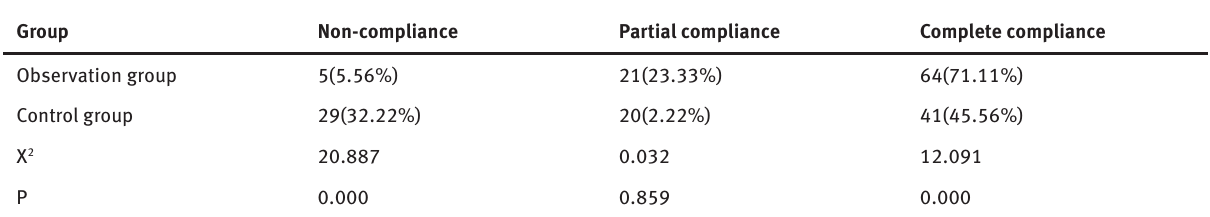
Table 3: Comparison of BPRS, MRSS scale scores of the two